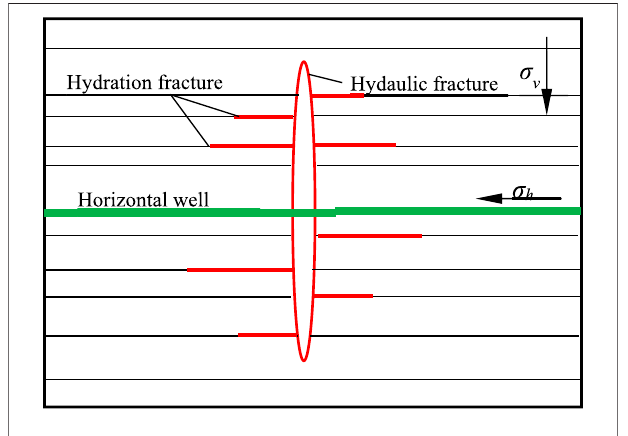
FIGURE 10 | In fl uence of hydration fracture to hydraulic fracturing.